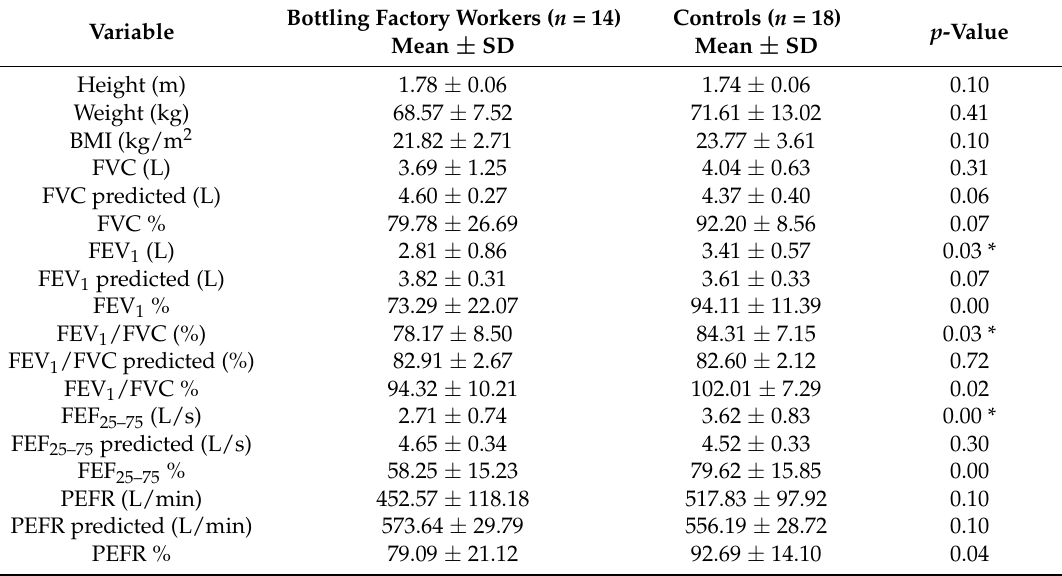
Table 3. Anthropometric and Spirometric Values of Bottling Factory Workers and Controls. Bottling Factory Workers ( n = 14) Variable Mean ±